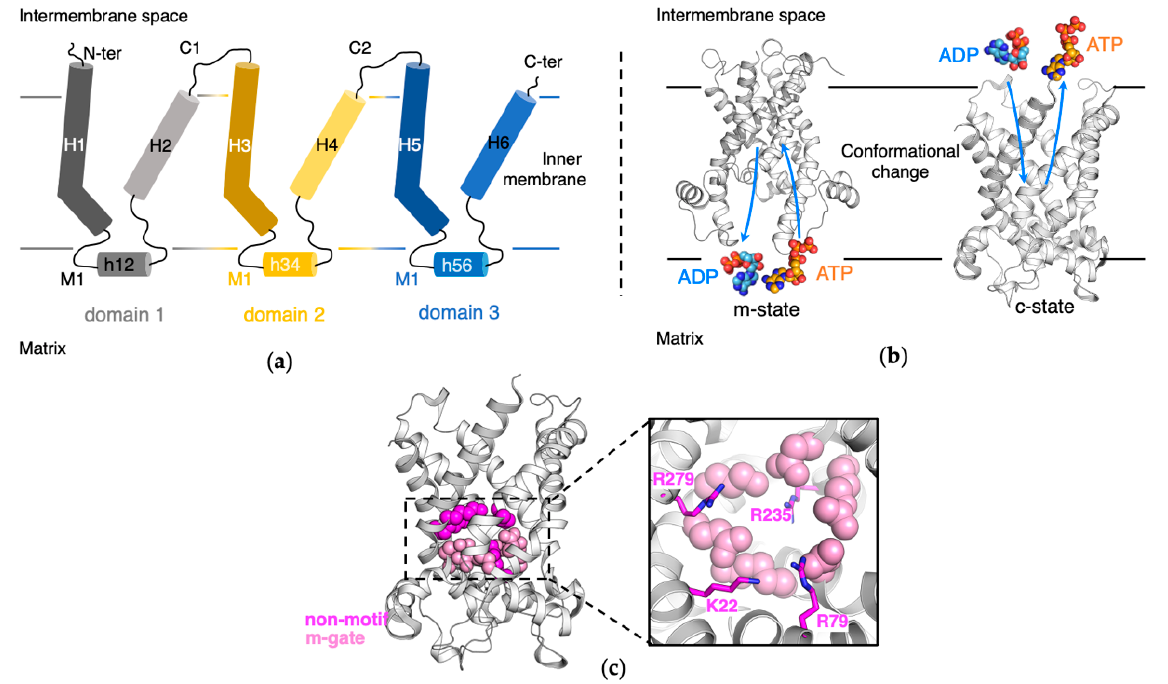
Figure 1. The schematic diagram of AAC’s tripartite structure and function. ( a ) AAC’s tripartite structure. Three domains of AAC are colored in grey, yellow and blue, respectively. ( b ) The schematic diagram of AAC’s function. The c-state (PDB: 1OKC [8]) and m-state (PDB: 6GCI [15]) AAC are shown in cartoon. ADP and ATP are shown in spheres. ( c ) The broad matrix gate in the c-state AAC. The charged residues from the Px[DE]xx[KR] motifs are shown as light pink spheres, and the non-motif charged residues are colored as magenta.